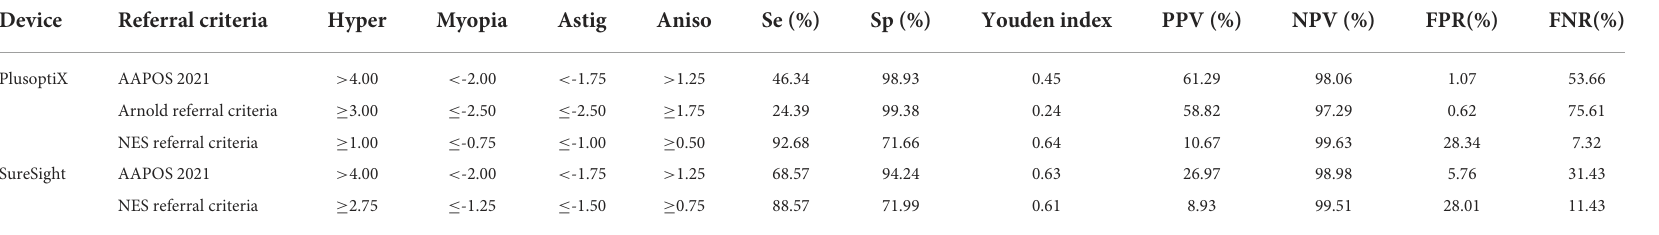
TABLE 4 Assessment and optimization of two refractive instrument-based methods for detecting refractive